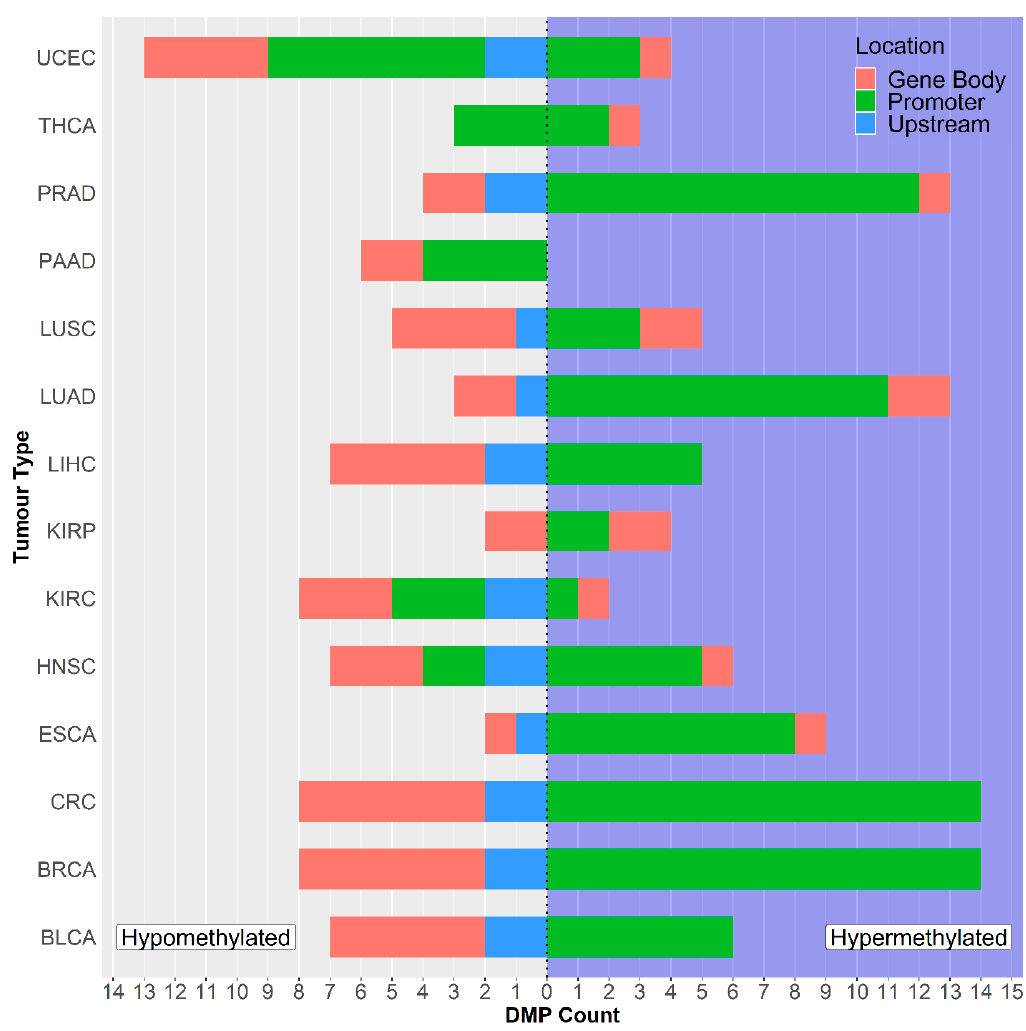
Figure 1. Countplot showing the number of di ff erentially methylated Gasdermin E ( GSDME ) probes across the datasets. The right panel corresponds to hypermethylated (DNA methylation beta values of tumor samples are significantly higher than that of normal samples) CpGs, while the left panel corresponds to hypomethylated (DNA methylation beta values of tumor are significantly lower than that of normal) CpGs. Please refer to Table 1 for tumor dataset abbreviations.